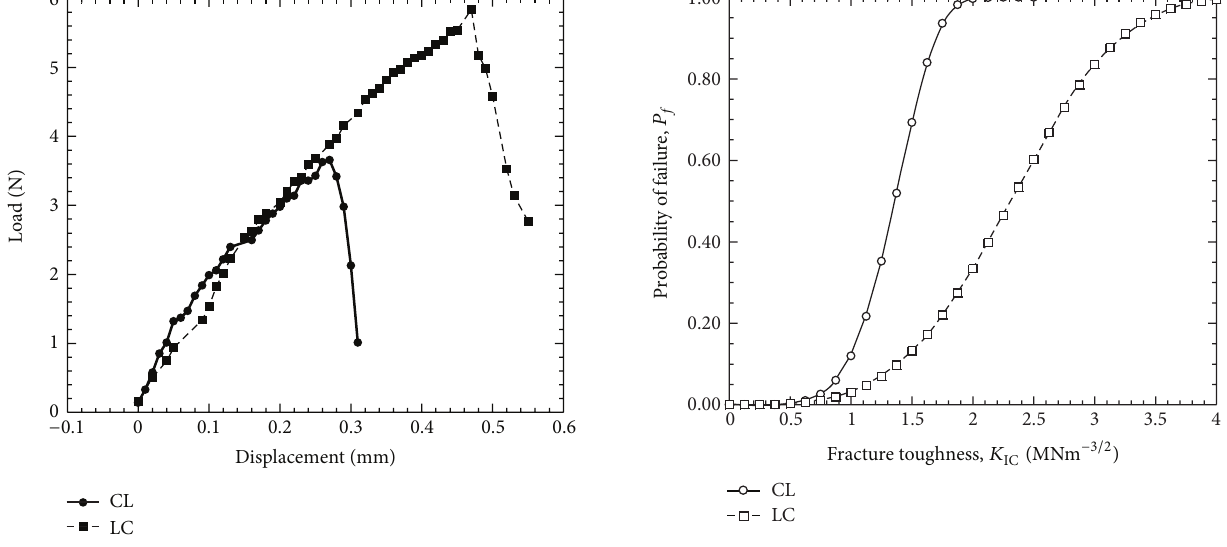
Figure 3: Typical load-displacement curves of a CL and LC specimen.